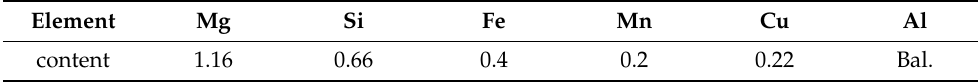
Table 1. Chemical compositions of 6061 aluminum sheets (massfraction/%). Element Mg Si Fe Mn Cu Al content 1.16 0.66 0.4 0.2 0.22